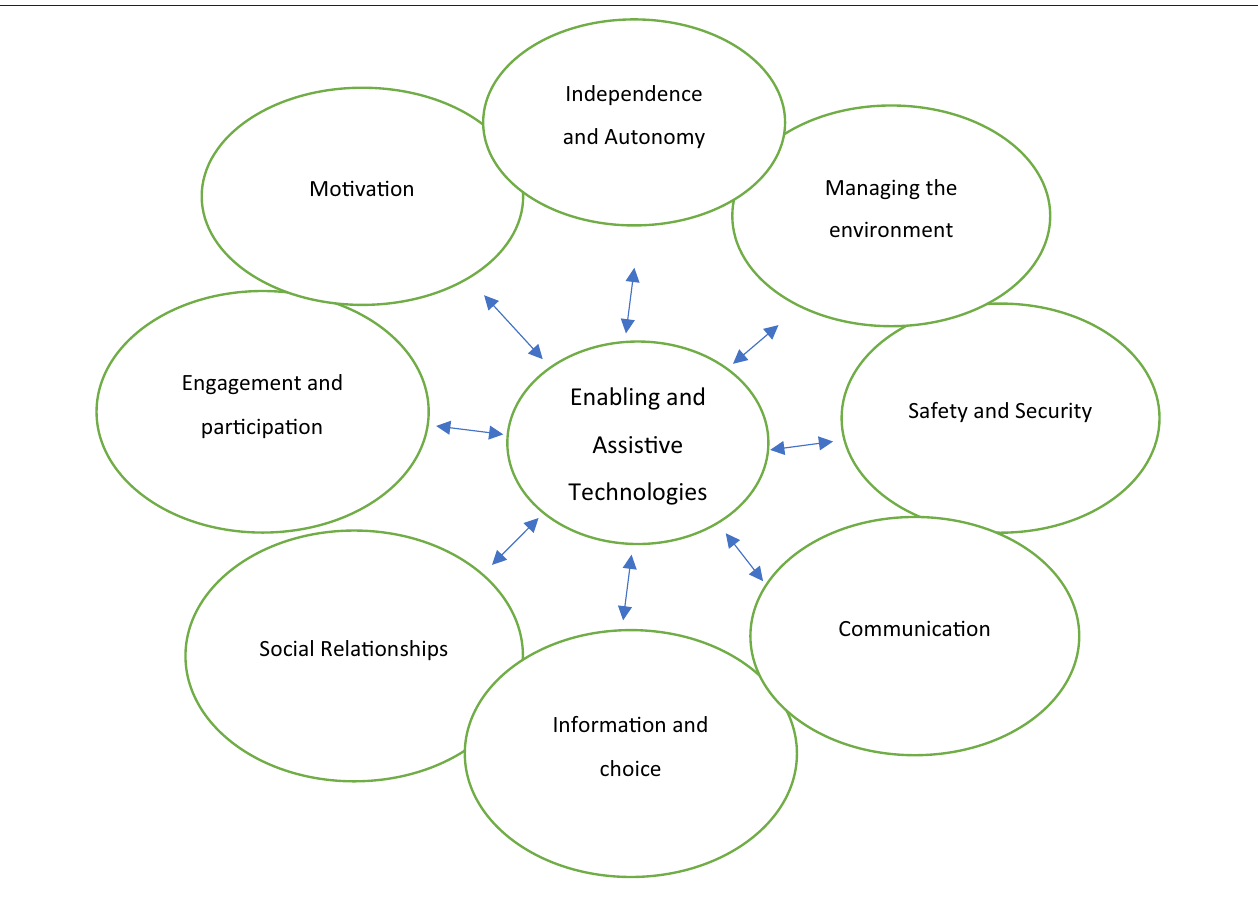
FIGURE 1 | Technology in the promotion of health and wellbeing in older women.